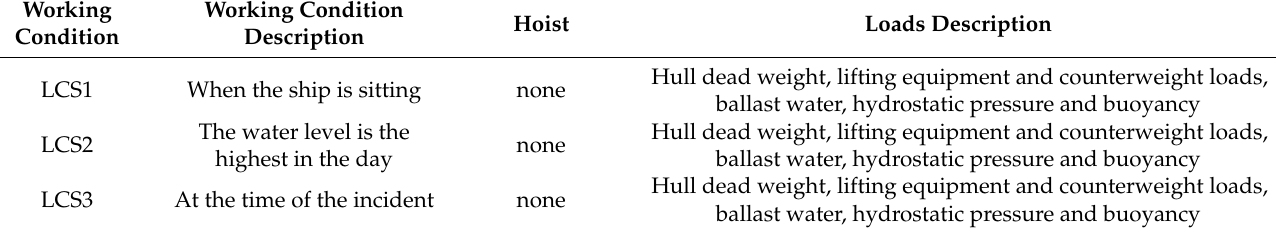
Figure 18. Schematic diagram of LCS3 ballast water distribution. Table 4. Load Cases.